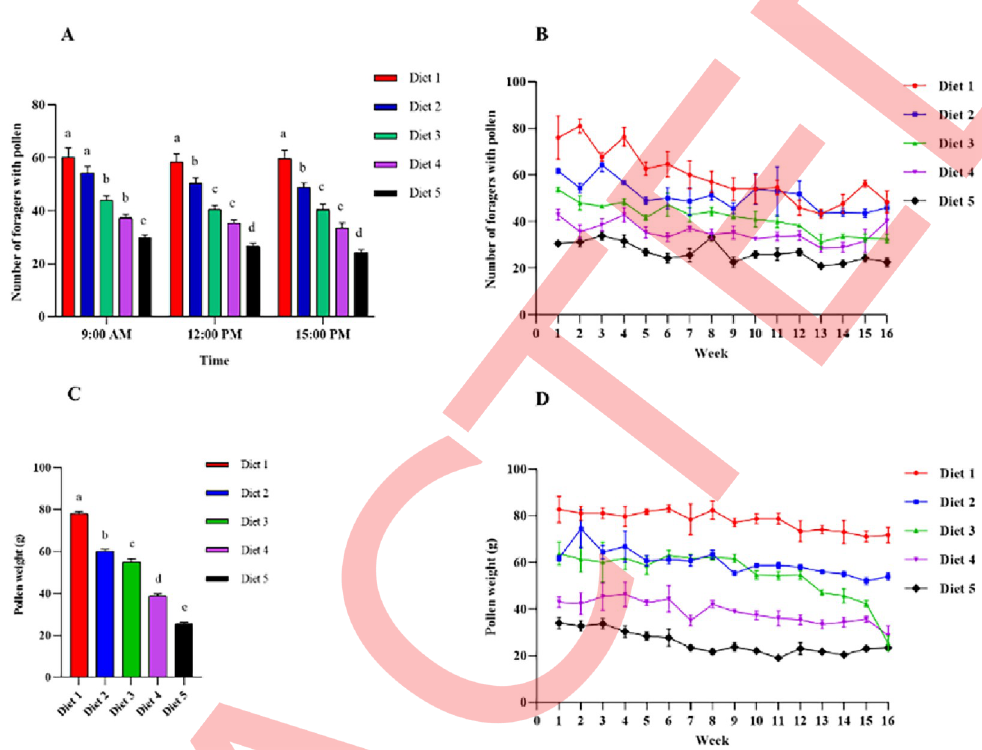
Fig 2. The foraging effort and pollen collection weight (shows as mean ± standard error) by consumption of various diets. (A), the mean number of bees with pollen was recorded at 9:00 AM, 12:00 PM, and 15:00 PM. (B), the mean number of foragers were detected per week per colony. (C), the mean collected pollen weight by use of various diets. (D), the mean collection of pollen weight per week per colony. The different small letter within each data represents statistically significant differences (p < 0.05).